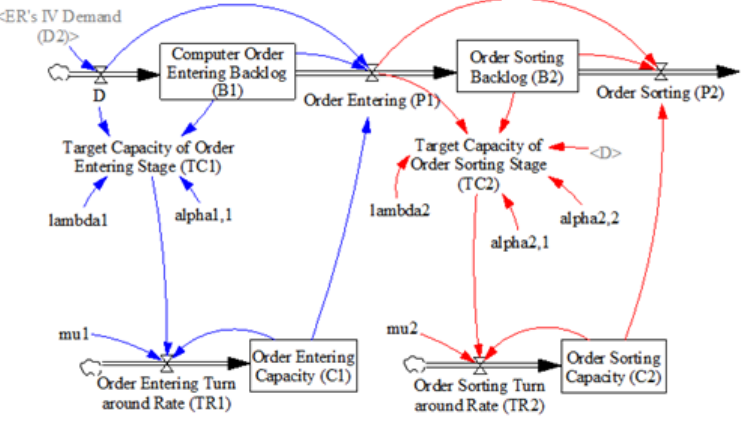
Figure 1. Pharmacy service supply chain model for the first two